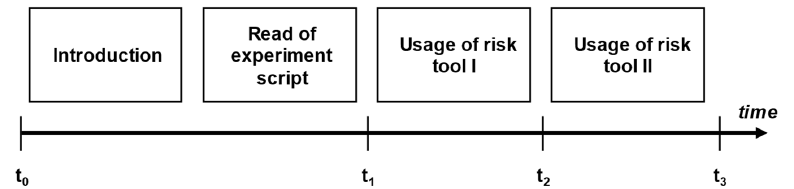
Figure 11. Visual representation of the experiment. Initially, between t 0 and t 1 , the users were introduced to the problem together with the experiment clarification, which also had explanatory steps for the task they had to accomplish. Afterwards, between t 1 and t 2 , the first interaction with one of the risk tools was performed, which concluded with filling out the SUS at time t 2 . Finally, between t 2 and t 3 , the second interaction with the other tool occurred and concluded with filling out the SUS scale at t 3 .